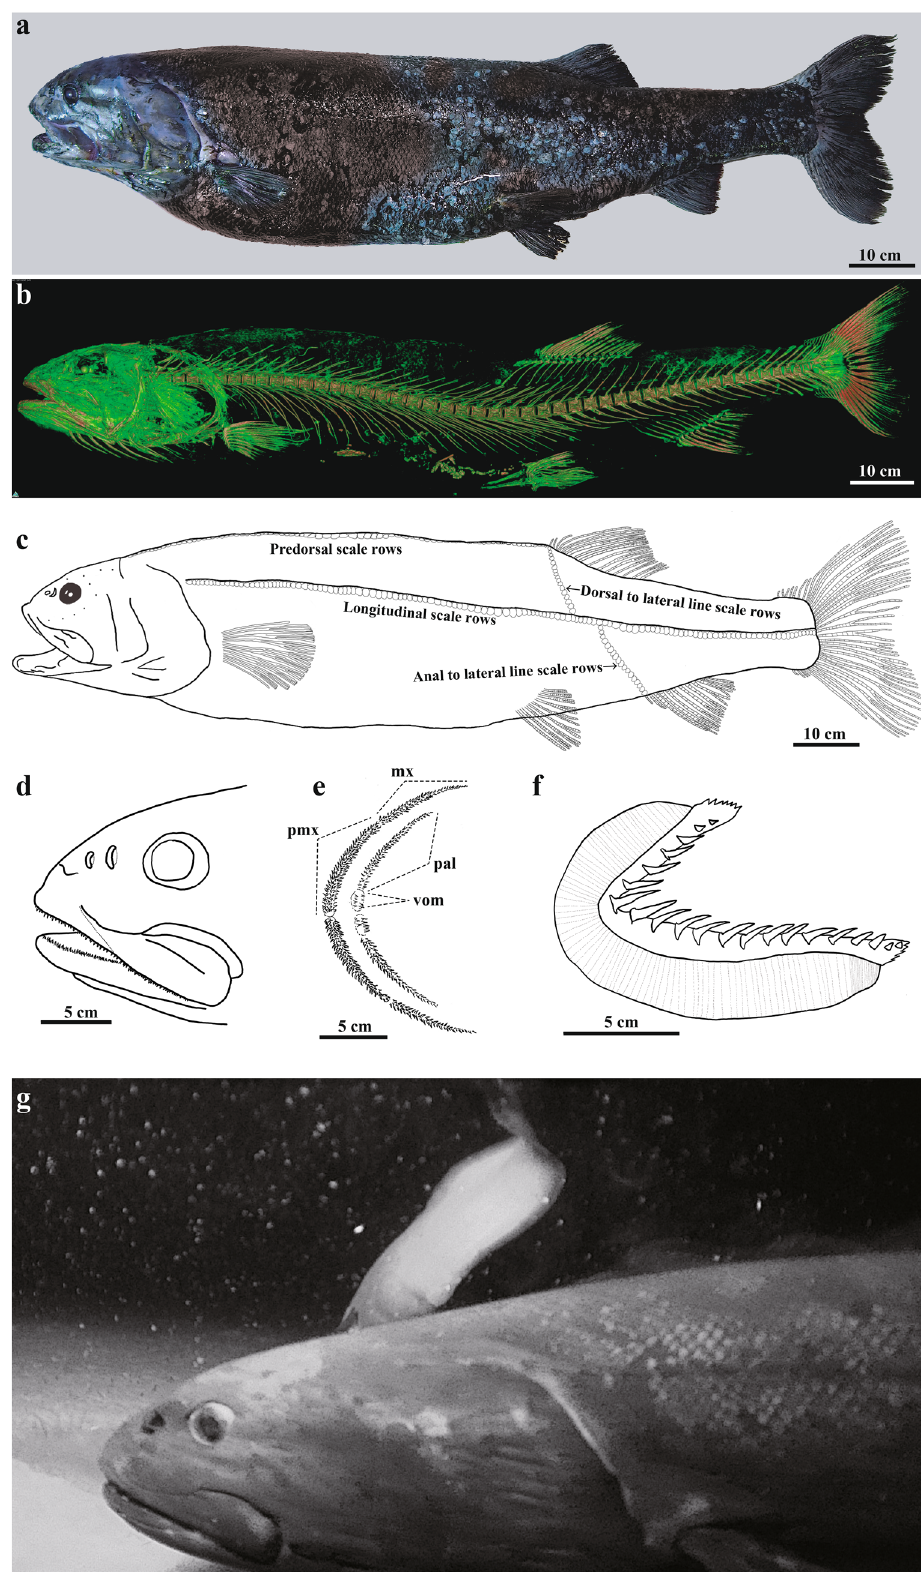
Figure 2. Narcetes shonanmaruae . ( a ), ( b ), ( d ), ( e ) holotype (SH8-69). ( c ) paratype 3 (SH12-14). ( f ) paratype 2 (SH12-1). ( a ) Lateral view. ( b ) Computed tomography image of the endoskeleton. ( c ) Lateral view. Scale rows indicated. Lateral line scales not shown. ( d ) Lateral view of head. ( e ) Tooth pattern of upper jaw. mx: maxillary, pal: platine, pmx:premaxillary, vom: vomer. ( f ) Gill raker. Right side of first arch. ( g ) In situ video grab of active swimming individual recorded using a baited